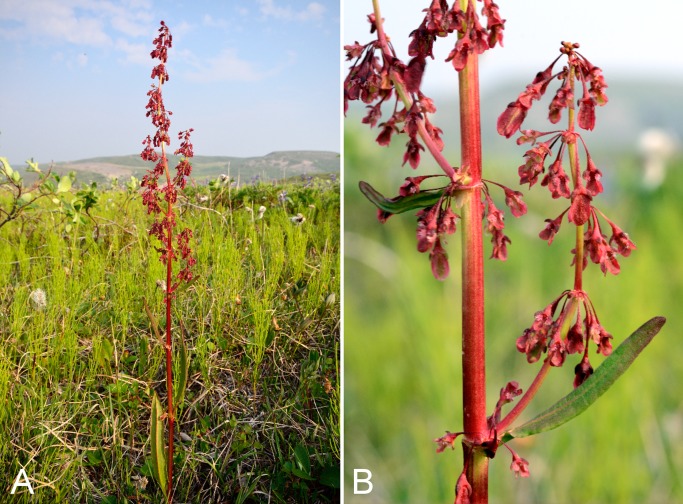
Rumex arcticus.(A) Habit, Saarela et al. 3925. (B) Inflorescence, Saarela et al. 3925. Photographs R. D. Bull.